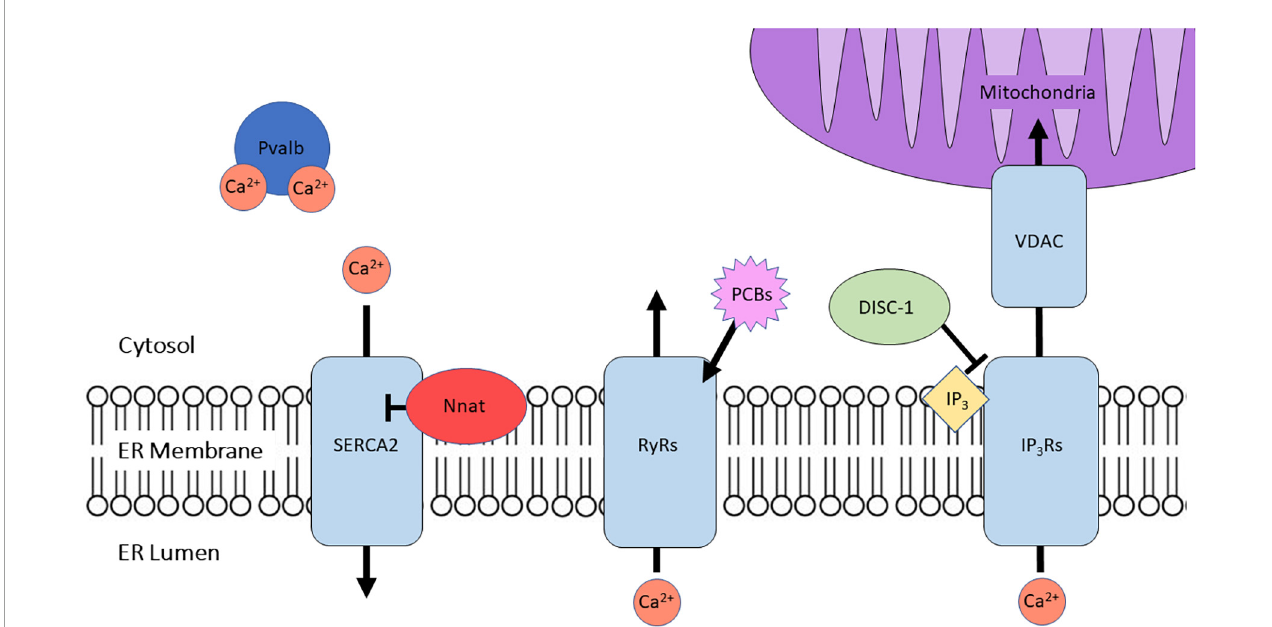
FIGURE1 A summary of the proteins discussed herein and their primary role in regulating intracellular Ca 2 + homeostasis. Proteins mediating ER Ca 2 + efflux include ryanodine receptors (RyRs) and inositol triphosphate receptors (IP 3 Rs), while cytosolic Ca 2 + is handled by the sarco-endoplasmic reticulum Ca 2 + ATPase 2 (SERCA2), which is negatively regulated by neuronatin (Nnat). Parvalbumin (Pvalb) regulates cytosolic Ca 2 + buffering via directly binding Ca 2 + ions. Polychlorinated biphenyls (PCBs) target RyRs to exert their effects on Ca 2 + homeostasis. IP 3 Rs associate with mitochondrial voltage-dependent anion channels (VDAC) in the mitochondrial-associated membranes (MAMs), and are regulated in part by disrupted in schizophrenia 1 protein